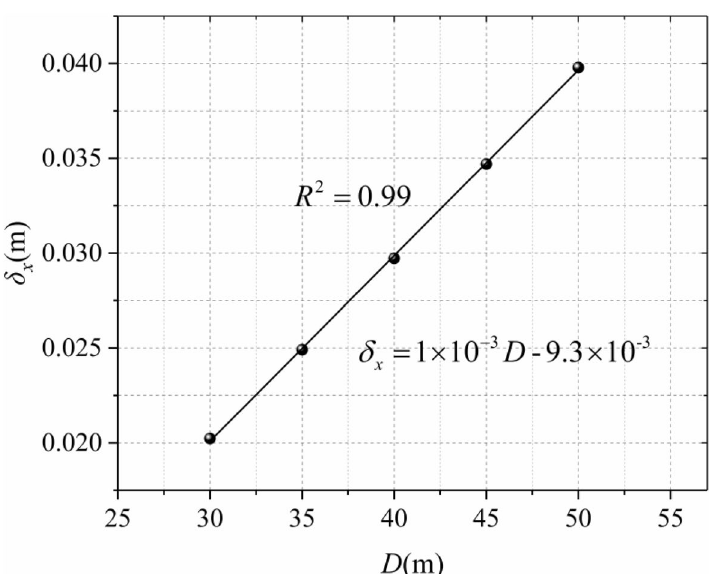
Figure 11. Maximum horizontal displacement of different excavation